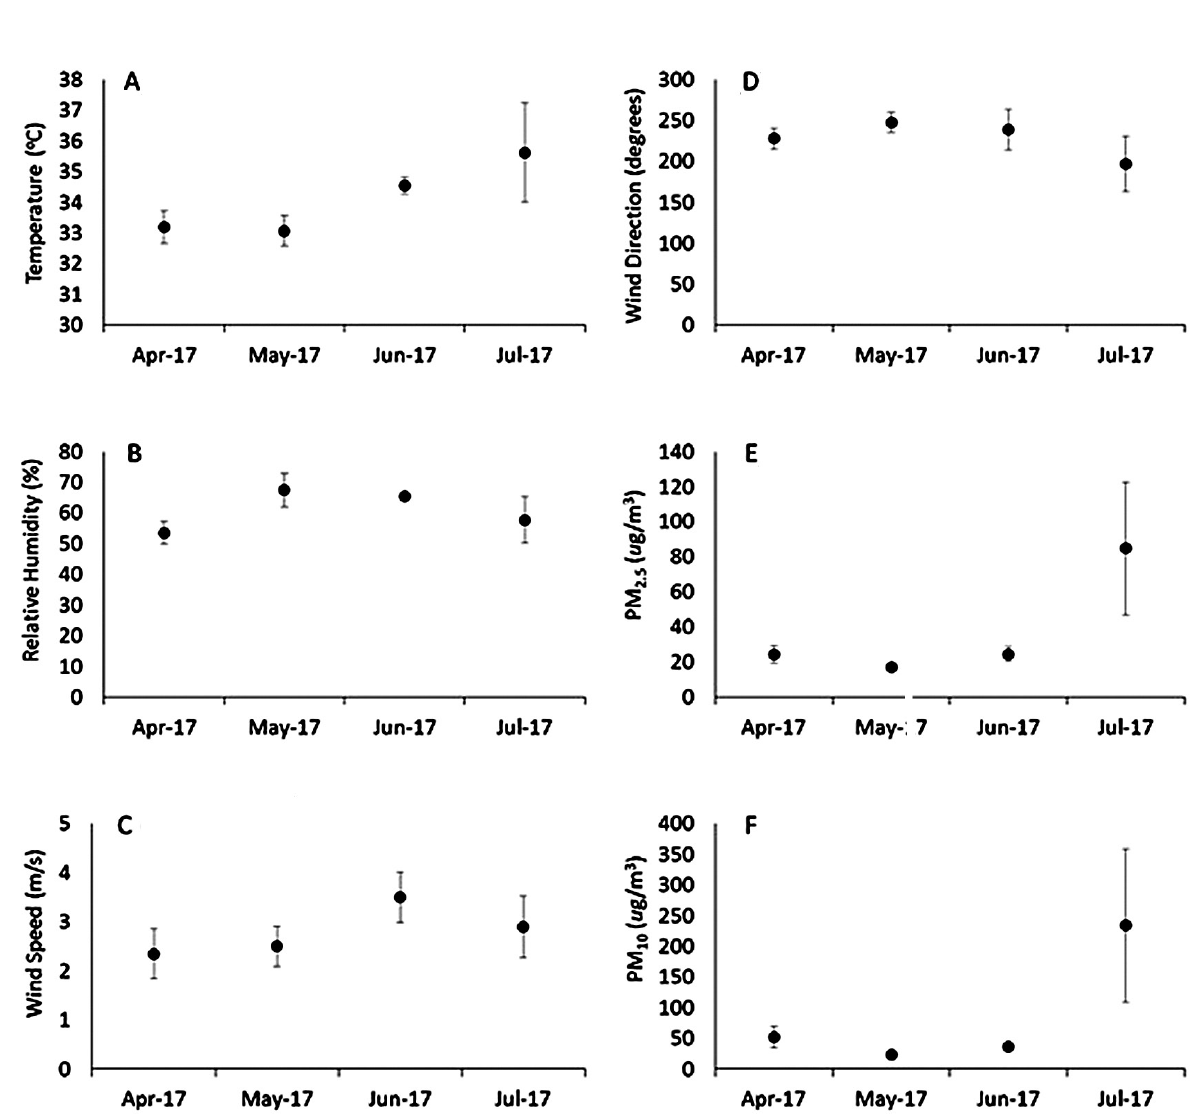
Fig. 3. – Average measurements of air temperature (A), relative humidity (B), wind speed (m s –1 ) (C), wind direction (D); and dust concentration